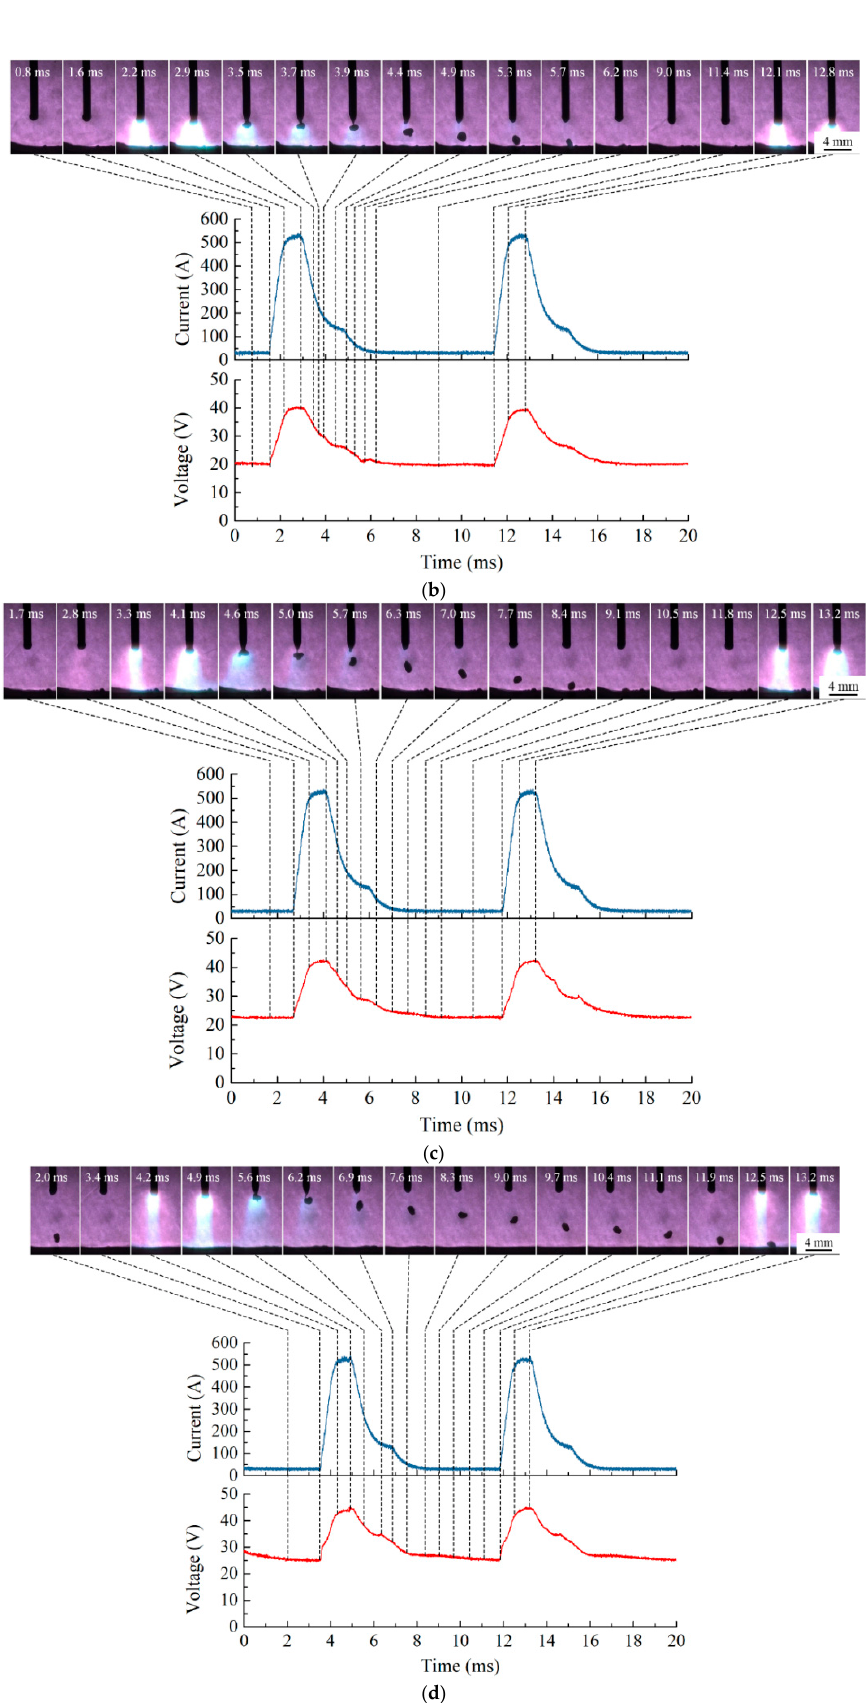
Figure 5. High-speed photographic images of droplets under different arc lengths. Arc length: ( a ) 2.9 mm; ( b ) 4.5 mm; ( c ) 6.5 mm; ( d ) 9.2 mm.